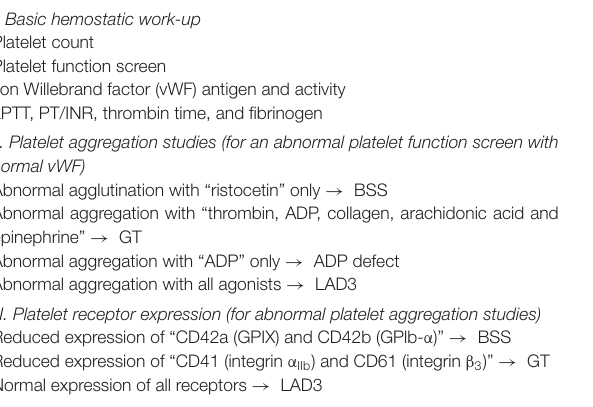
TABLE 2 | Schema diagram summarizing the hemostatic